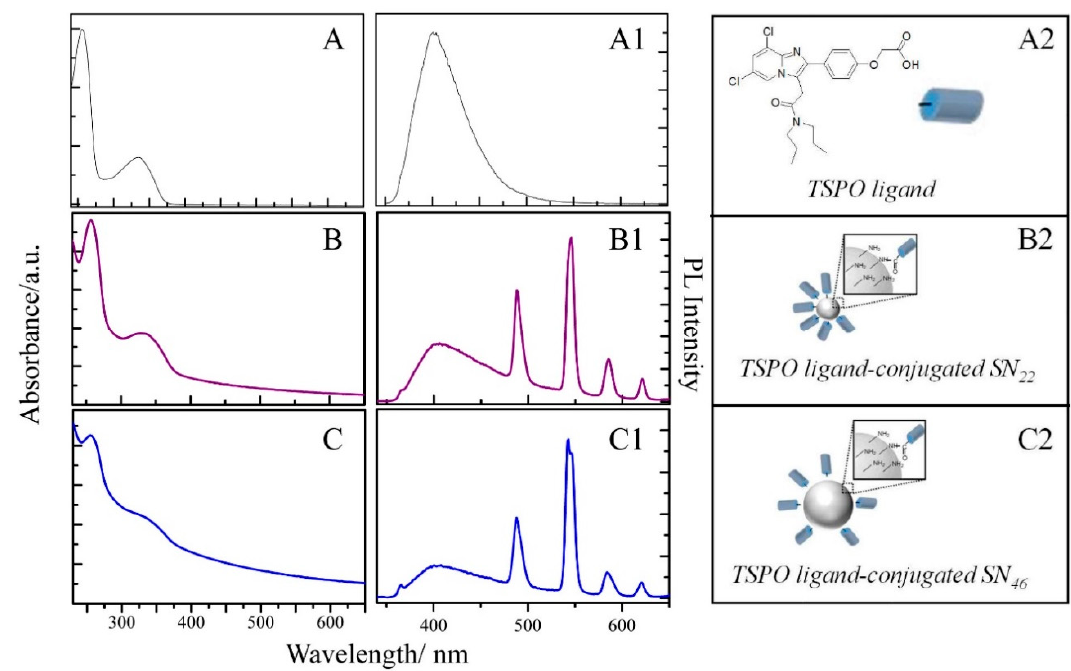
Figure 3. UV-Vis absorbance ( A , B , C ) and emission (A1,B1,C1) spectra of the TSPO ligand (A,A1, molecular sketch in panel A2), TSPO ligand-conjugated SN22 (B,B1, sketch of the multifunctional NP in panel B2) and SN46 (C,C1, sketch of the multifunctional NP in panel C2).